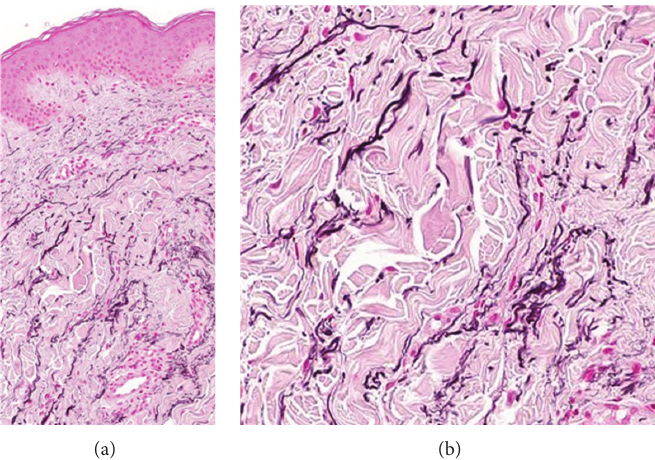
F 14: Linear focal elastosis. Accumulation of fragmented elastotic material within the papillary dermis (a, b) and transcutaneous elimination of elastotic �bers ( 20 and × ×